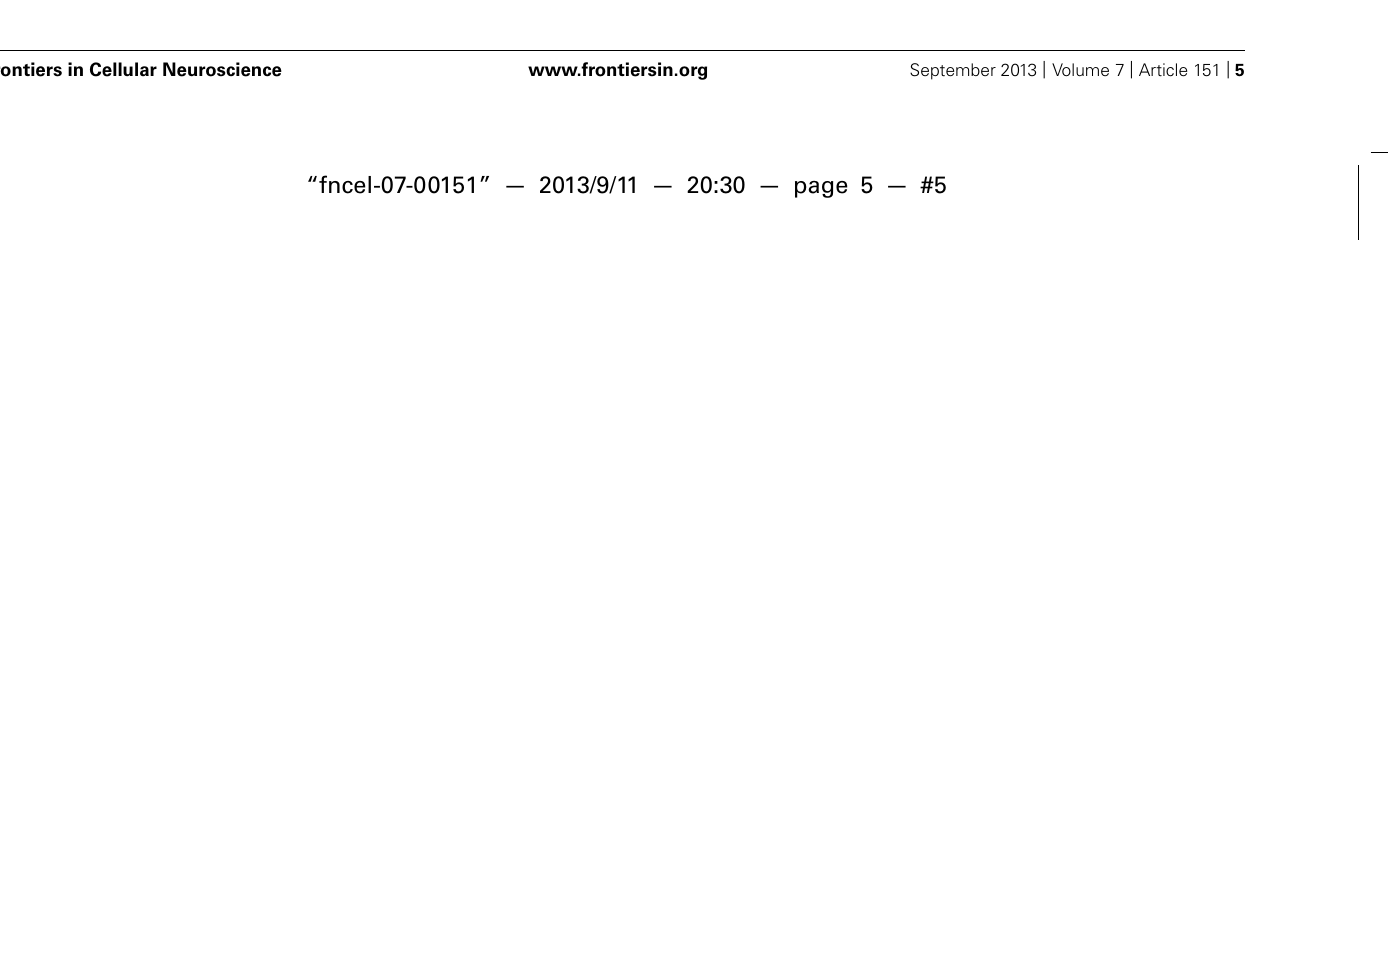
cortices compared to controls.The dashed box indicates the area of quantification. (E) TUNEL assay of coronal cryosections of P5 control and Dicer Ko cortices.The dashed box indicates the region shown at higher magnification in panel a (cid:2) , b (cid:2) . (F) Normalized quantification ofTUNEL + cells per area in the cortical wall of P5 control and Dicer Ko brains. Cortical layers (VI), (V), and (II/III) are labeled. Scale bar: 100 μ m. Data are presented as mean ± SEM; n ≥ 3 in all genotypes; p values in relation to control (* p < 0.04, *** p < 0.0002). n.s., not